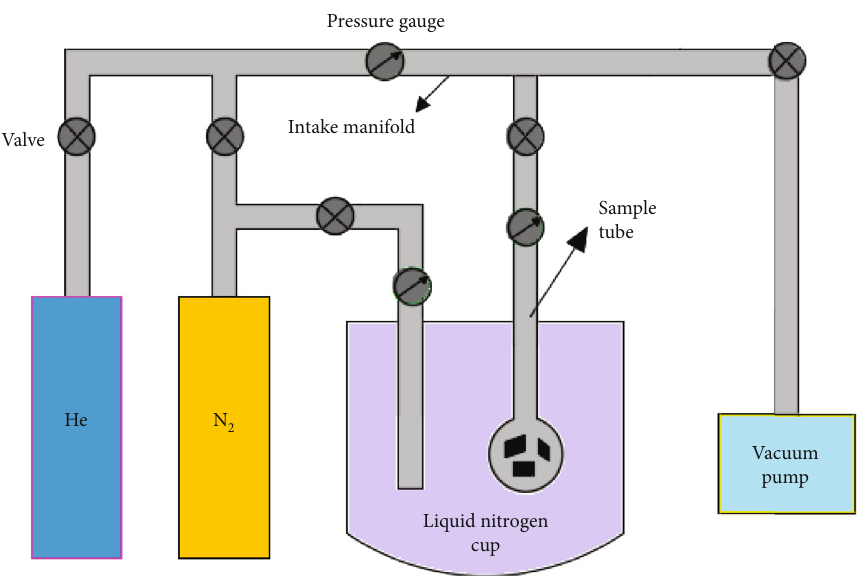
Figure 4: Schematic diagram of the low-temperature nitrogen adsorption experimental